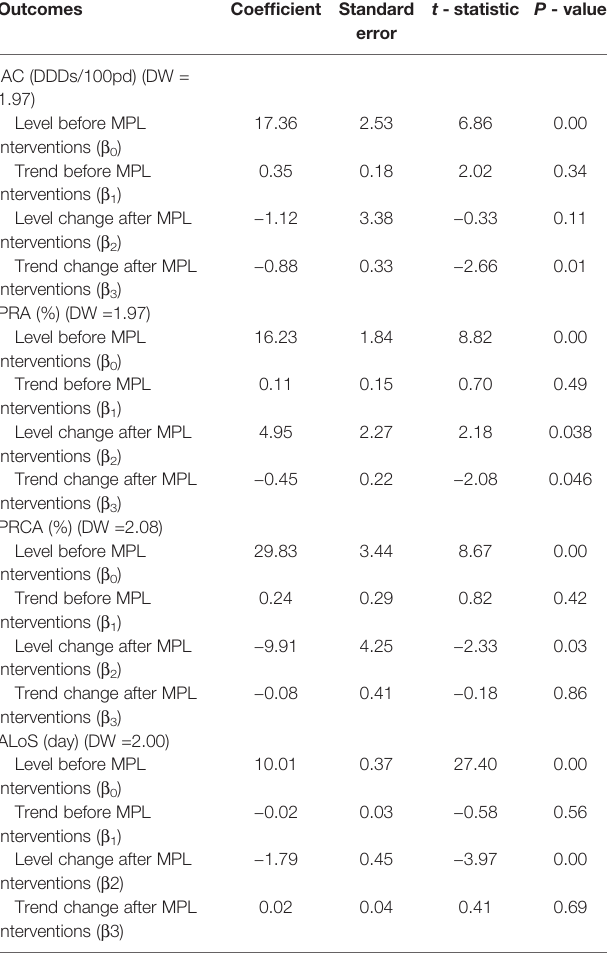
TABLE 2 | Results of the segmented regression analysis of IAC, PRA, PRCA, and ALoS.